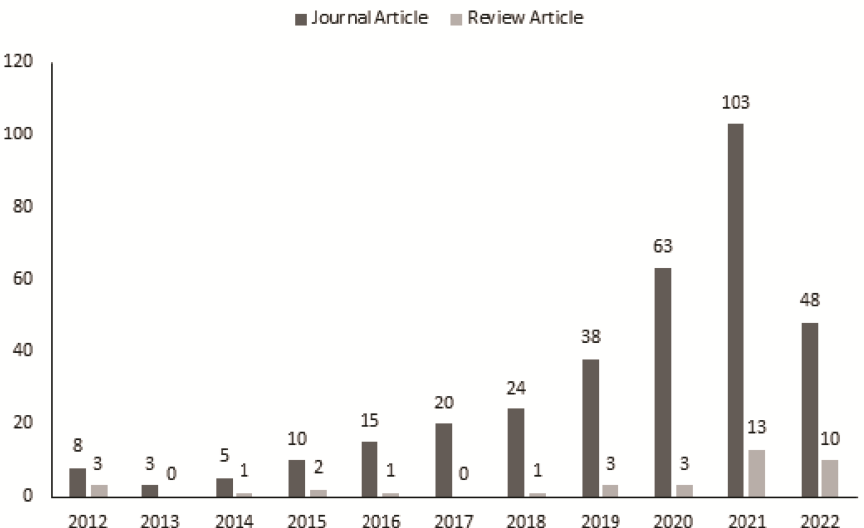
Figure 4. Published articles count for the last 10 years for both review and journal articles.